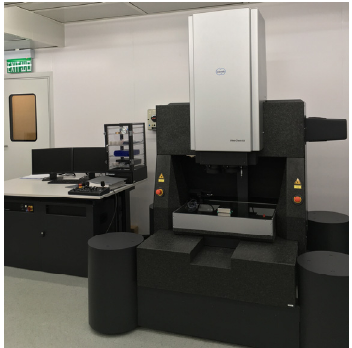
Figure 4. Werth VideoCheck UA multi ‐ sensor CMM (coordinate measuring machine) used for the experiments.